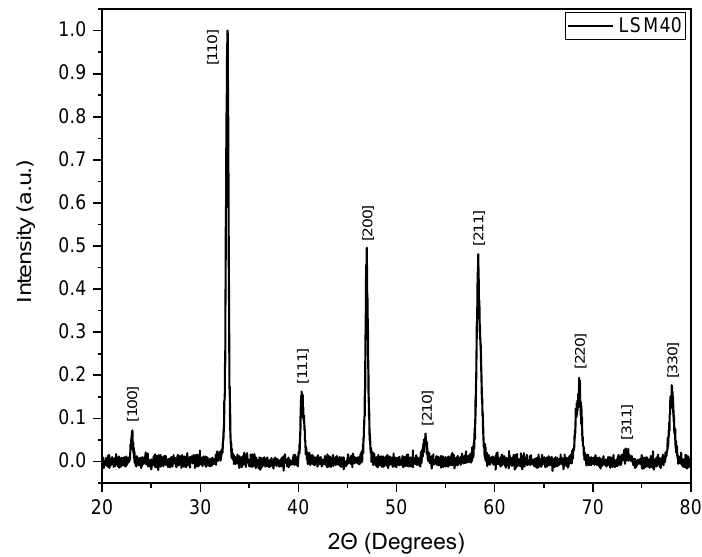
Figure 2. X-ray di ff raction (XRD) patterns of the fresh LSM40 Figure 2. X-ray diffraction (XRD) patterns of the fresh LSM40 powder.